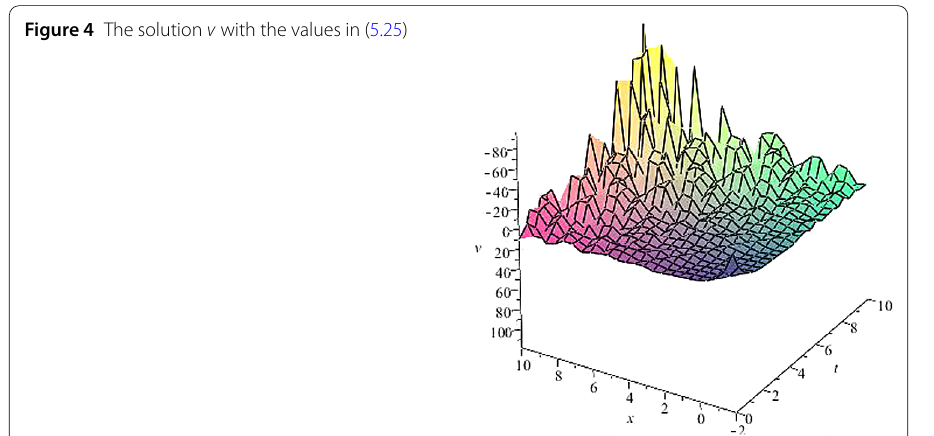
Figure 4 The solution v with the values in